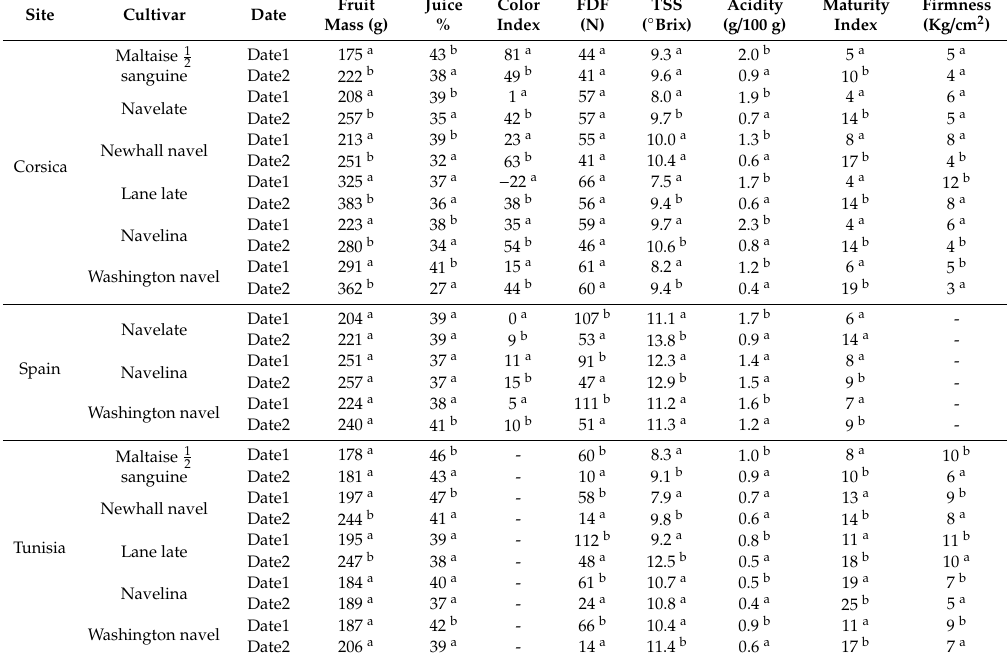
Table 2. Statistical analysis of variations in fruit parameters during maturation. The di ff erent letters indicate statistically significant di ff erences ( p ≤